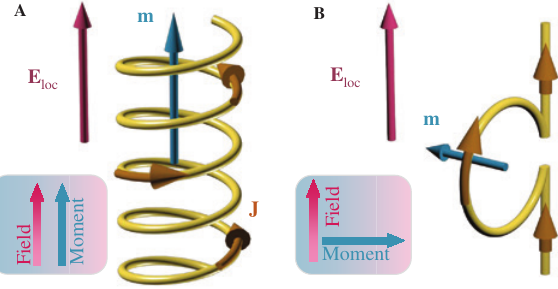
Figure 2: Topologies of two basic reciprocal bianisotropic inclusions. (A) A chiral metal inclusion with the shape of a true helix and (B) an omega inclusion with shape of the Ω